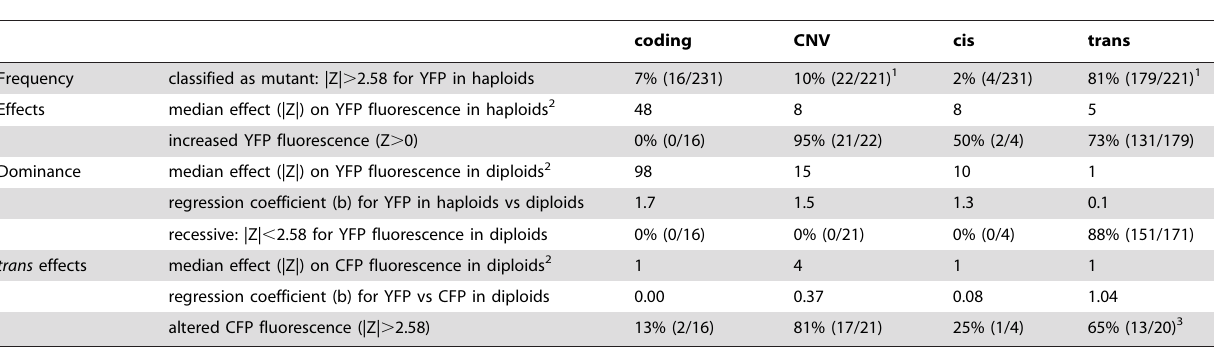
Table 1. Comparison of properties among mutational classes.